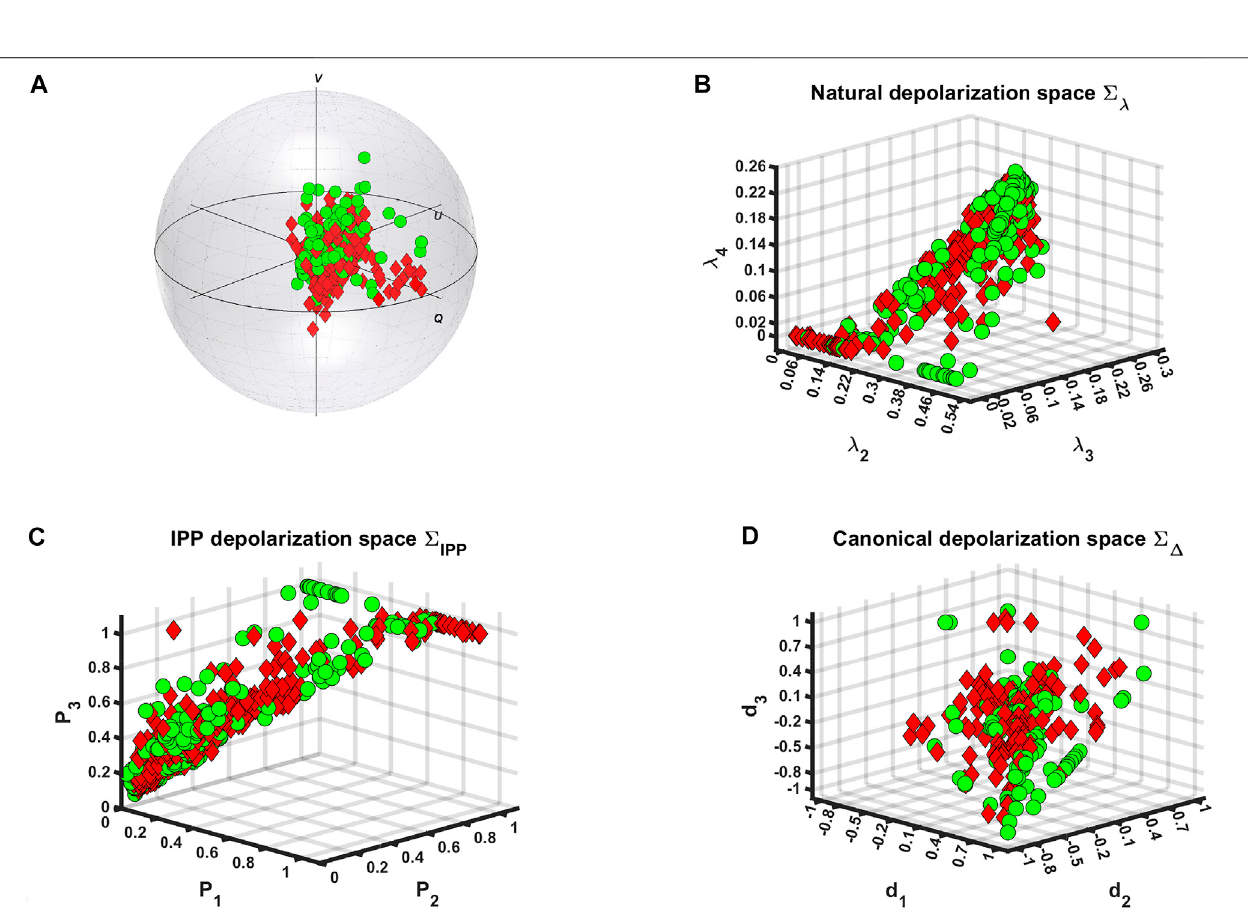
FIGURE 2 | Visualization of polarimetric data at all spatial locations for both colon tissue zones measurements ◦ — healthy and ◇ — tumor via : (A) Poincaré sphere for probing (or incident) circular polarization, (B) natural, (C) IPP, and (D) canonical depolarization spaces.